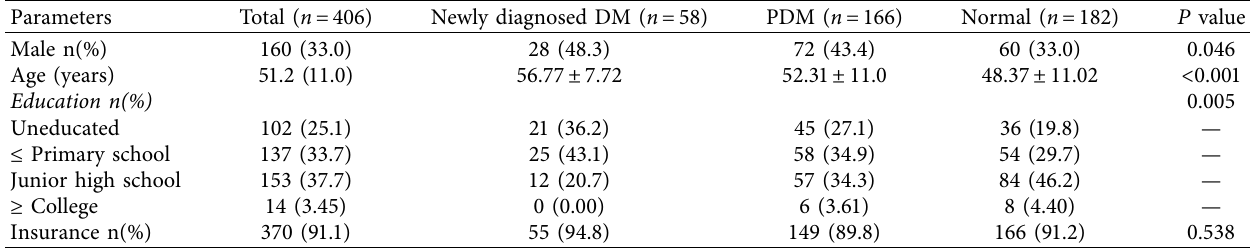
Table 1: Baseline sociodemographic characteristics of study participants.